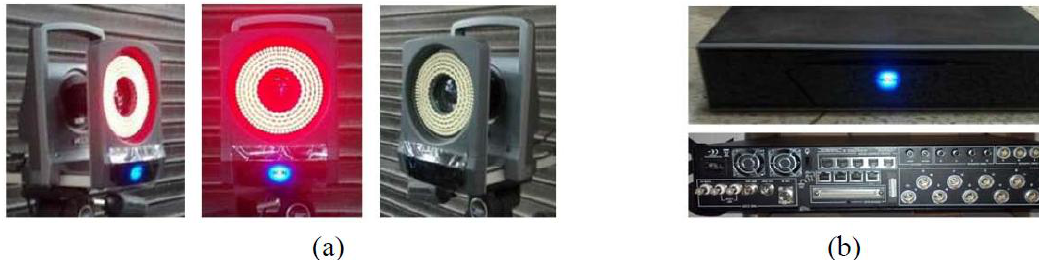
Figure 1. Motion-capture system. ( a ) Camera; ( b ) Vicon giganet.